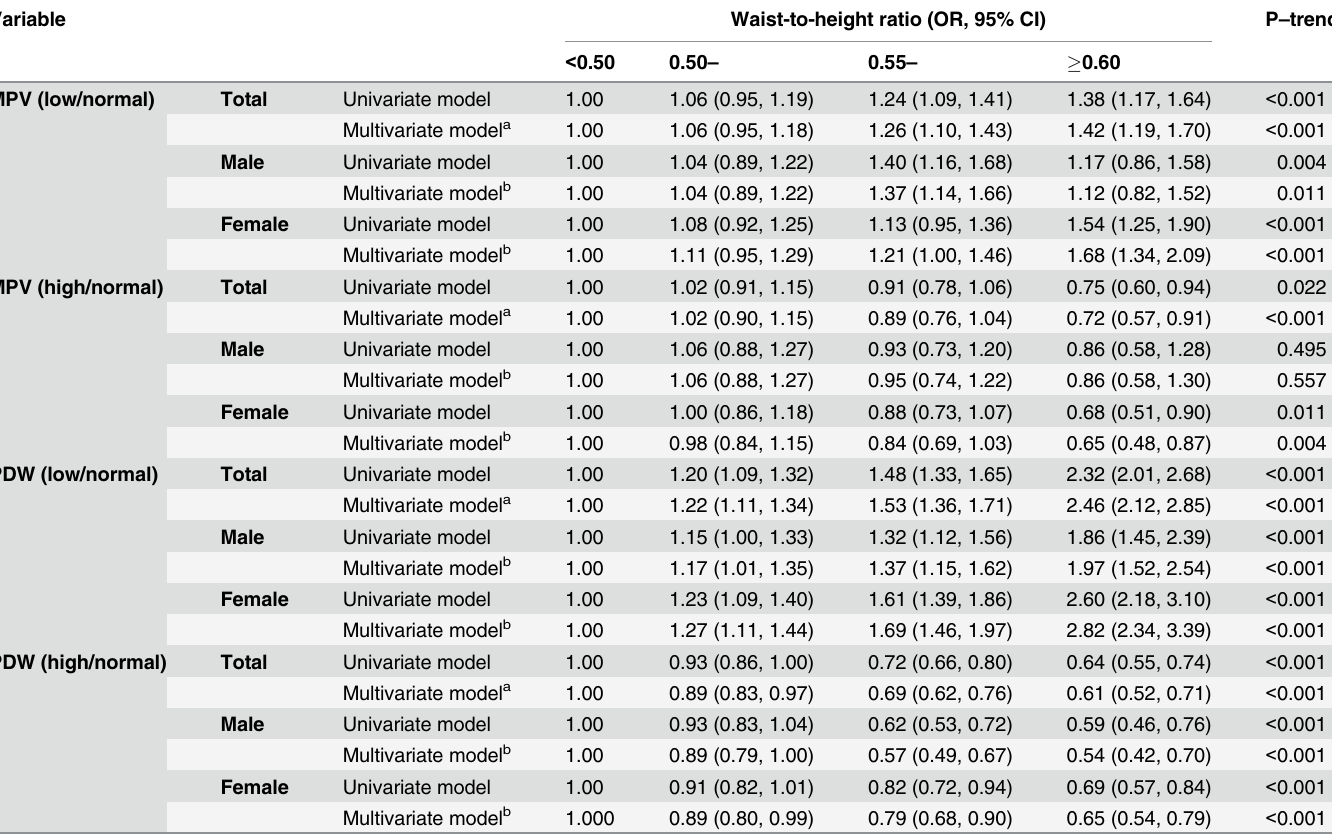
Table 4. Association between waist — to — height ratio and platelet indices among 17327 participants.